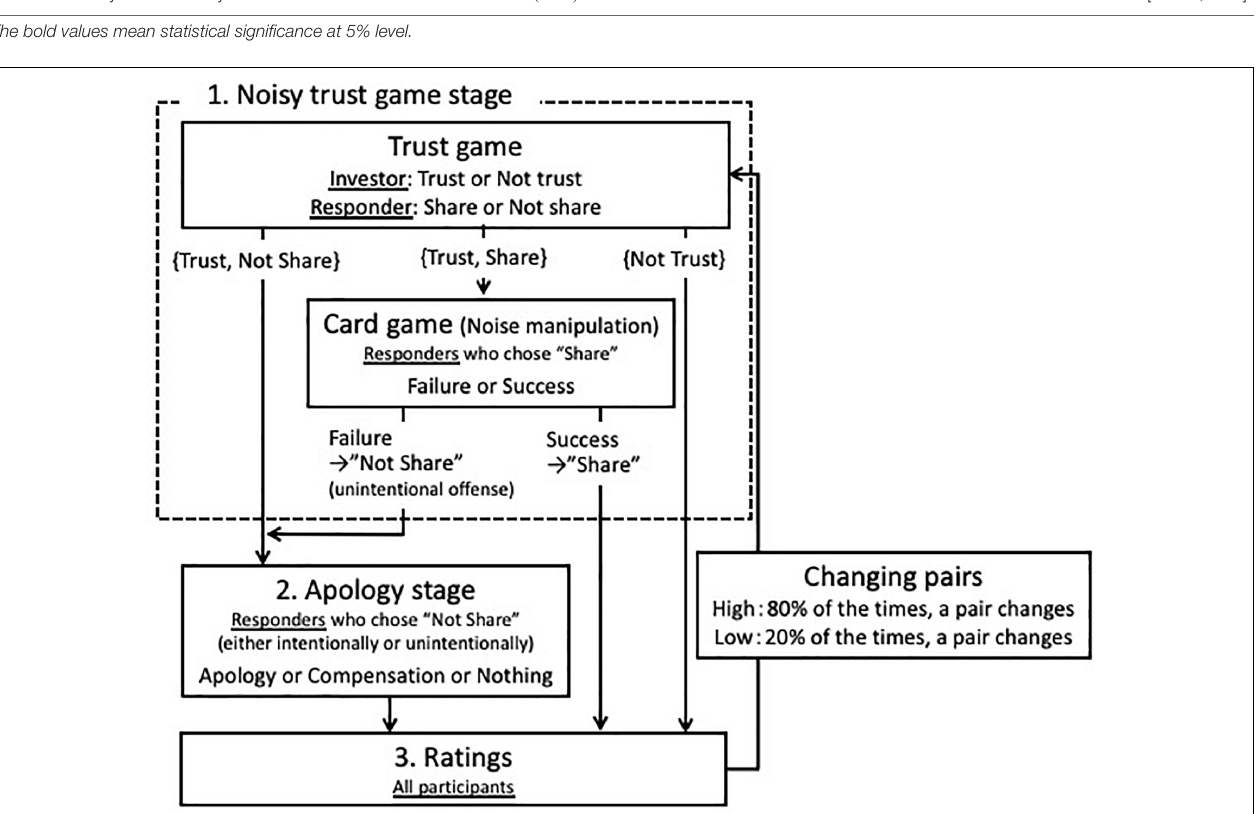
FIGURE 2 | A sequence of trade game. Further explanation is shown in Supplementary Material